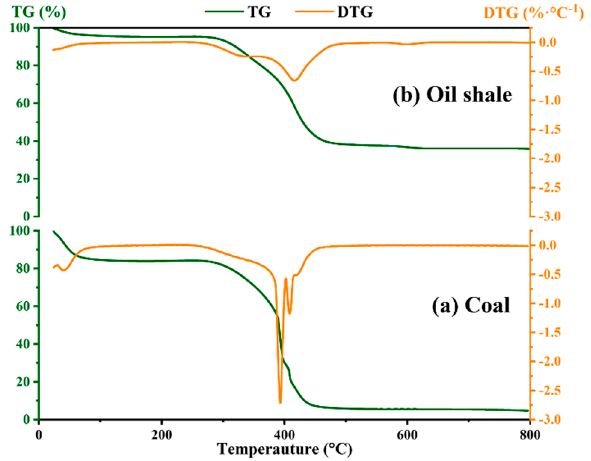
Figure 2. Thermogravimetric and derivative thermogravimetric (TG-DTG) curves of oil shale dust sample versus coal dust sample: ( a ) coal; ( b ) oil shale.